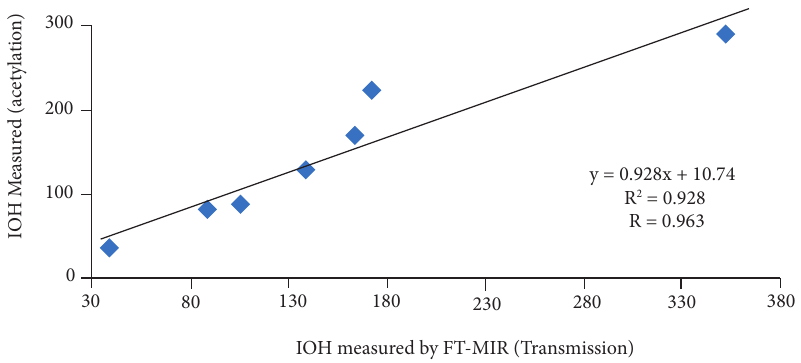
Figure 11. IOH values (measured by FT-MIR) versus IOH measured by wet chemistry method (acetylation) for the polyesters studied.